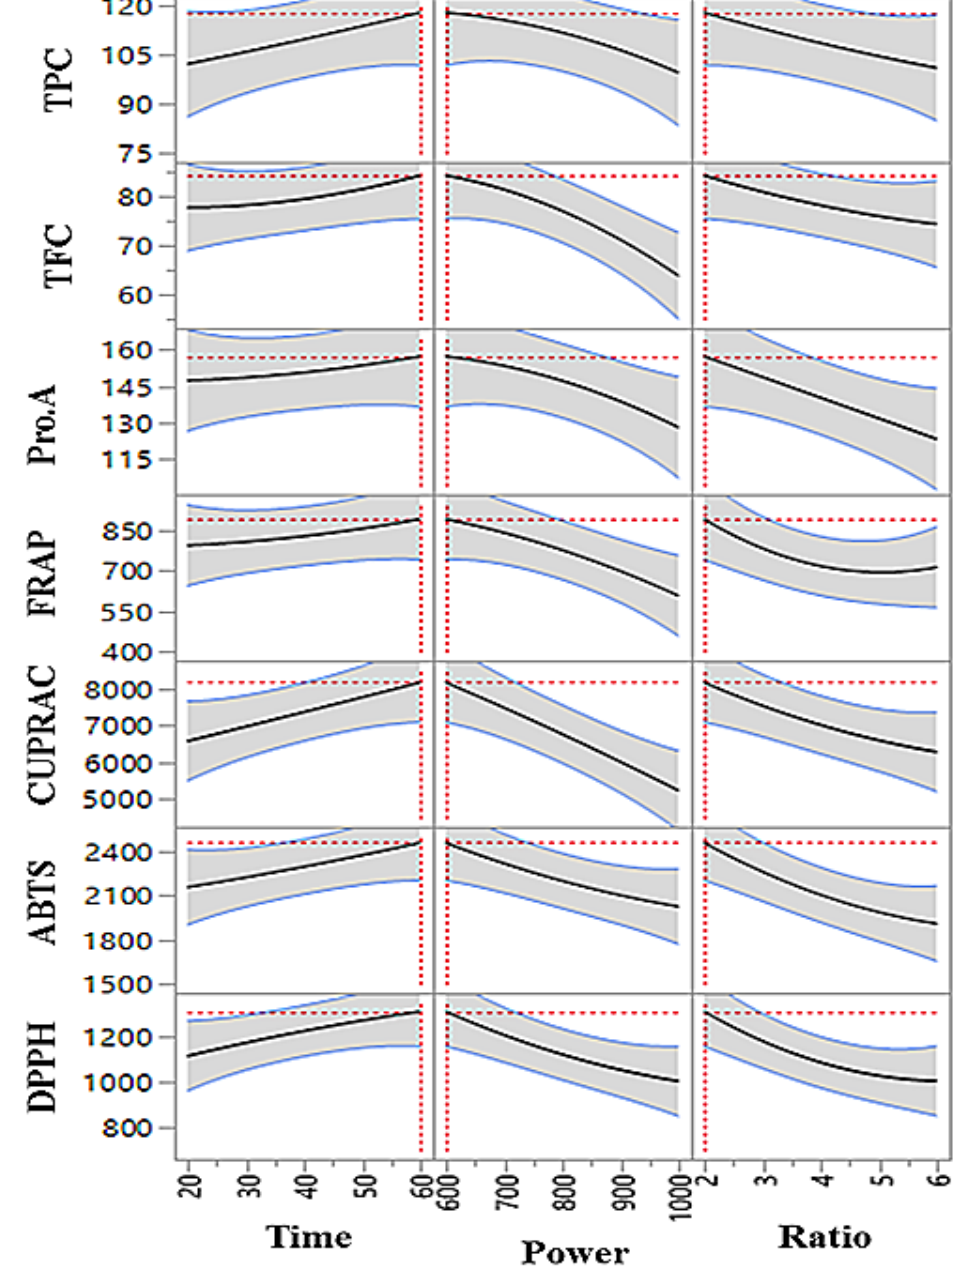
Figure 4. 2D contour plots of influence of extraction parameters on phenolic compound and antiox- idant capacity.